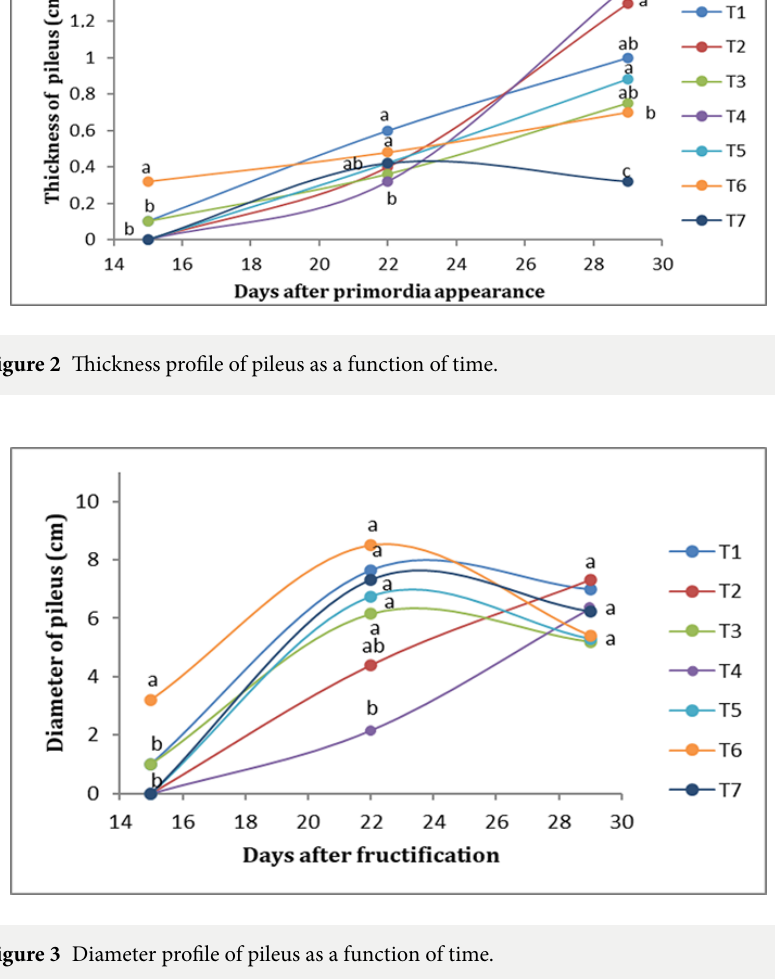
Figure 3 Diameter profile of pileus as a function of